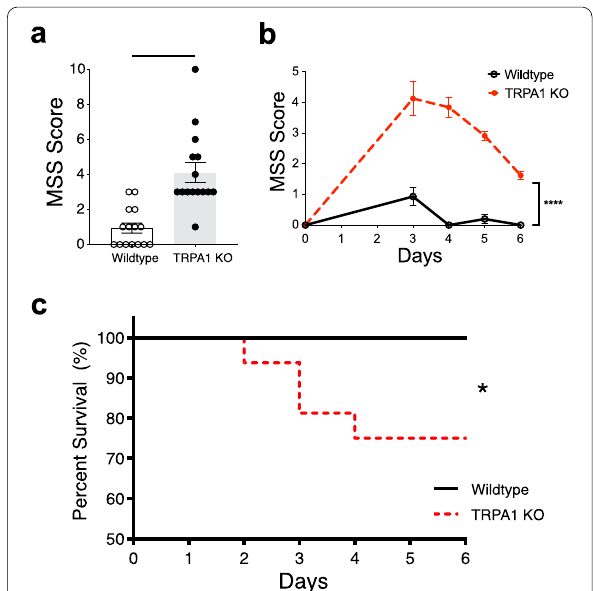
Fig. 6 TRPA1 is required to improve survival in experimental sepsis. a – c Wild type (B6.129PF) and TRPA1 KO mice were subjected to cecal ligation and puncture (CLP) procedure. a Murine Sepsis Score (MSS) assessed in wildtype (B6.129PF; n 15) and TRPA1 KO mice = (n 12–16) on day 3 post-CLP. Data is presented as individual mouse = data points with mean SEM. Unpaired t-test with Welch’s correction. ± ****p < 0.0001. b Murine sepsis scores assessed in wildtype (B6.129PF; n 15) and TRPA1 KO mice (n 12–16) on pre-CLP (Day 0) and = = post-CLP days (day 3, 4, 5, and 6). Data is presented as mean SEM. ± Mixed effects analysis; ****p < 0.0001. c Sepsis mortality rate in wildtype (B6.129PF; n 15) and TRPA1 KO mice (n 16) subjected = = to sublethal CLP. Sublethal CLP protects wildtype mice with